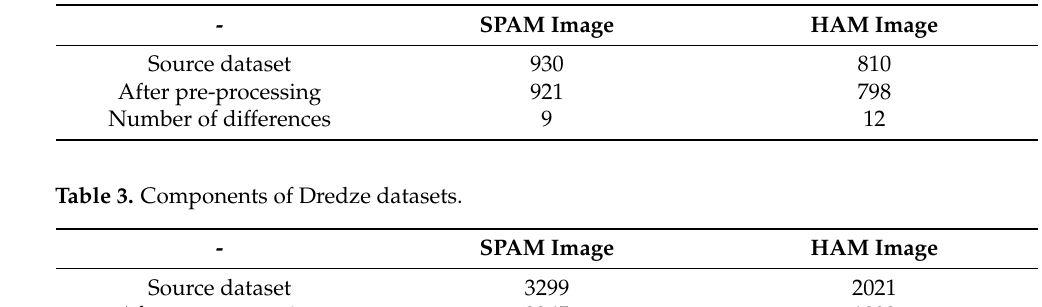
Table 2. Components of ISH datasets.